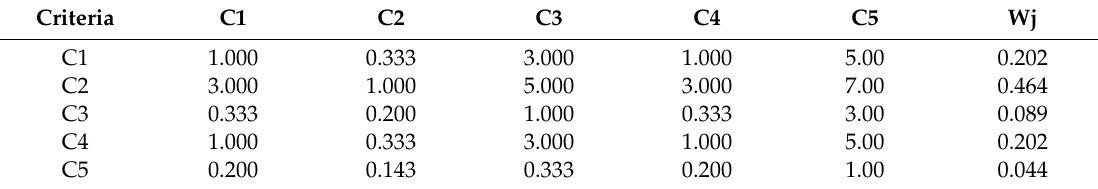
Table 1. Criteria pairwise comparison—the Analytic Hierarchy Process (AHP) method.